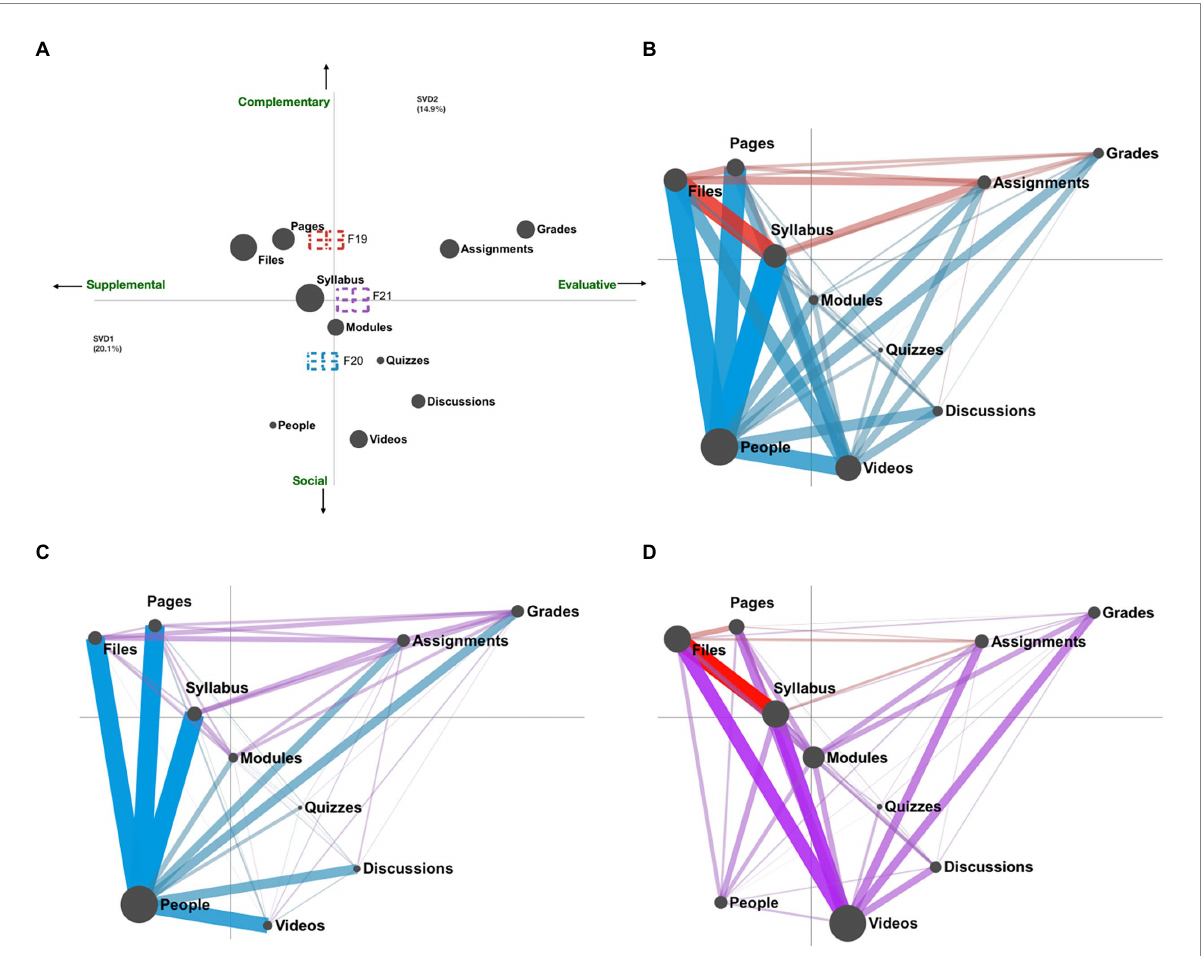
FIGURE 4 (A) ENA graph of the network means of the learning designs in three semesters (red: F19, blue: F20, purple: F21) with the mapping of the course types along the x and y axes; (B) Model 1: Comparison network of learning designs in F19 (red) and F20 (blue); (C) Model 2: Comparison network of learning designs in F20 (blue) and F21 (purple); (D) Model 3: Comparison network of learning designs in F19 (red) and F21 (purple).